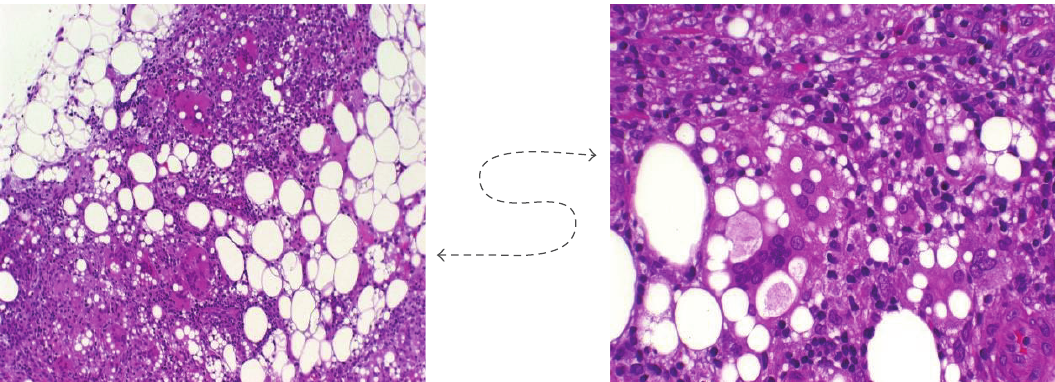
Figure 3: Chronic Edematous Panniculitis, histopathologic finding. Cellular reaction, with formation of fibrosis, and no giant cells.